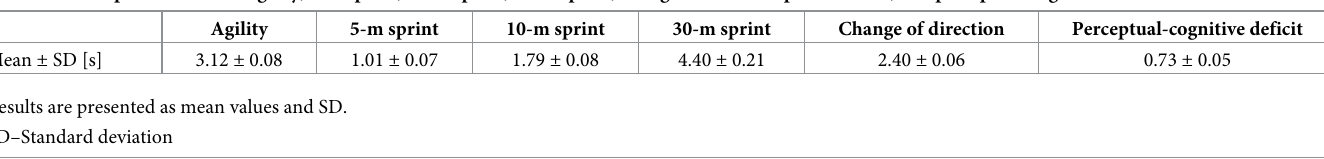
Table 1. Descriptive results for agility, 5-m sprint, 10-m sprint, 30-m sprint, change of direction performance, and perceptual-cognitive deficit.